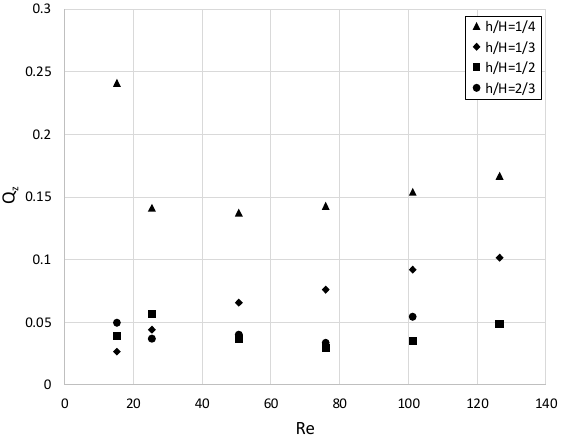
Fig. 5. Mean axial pumping capacity Q z / N · d 3 for Rushton turbine in function of Reynolds number and for different impeller distances from tank bottom.